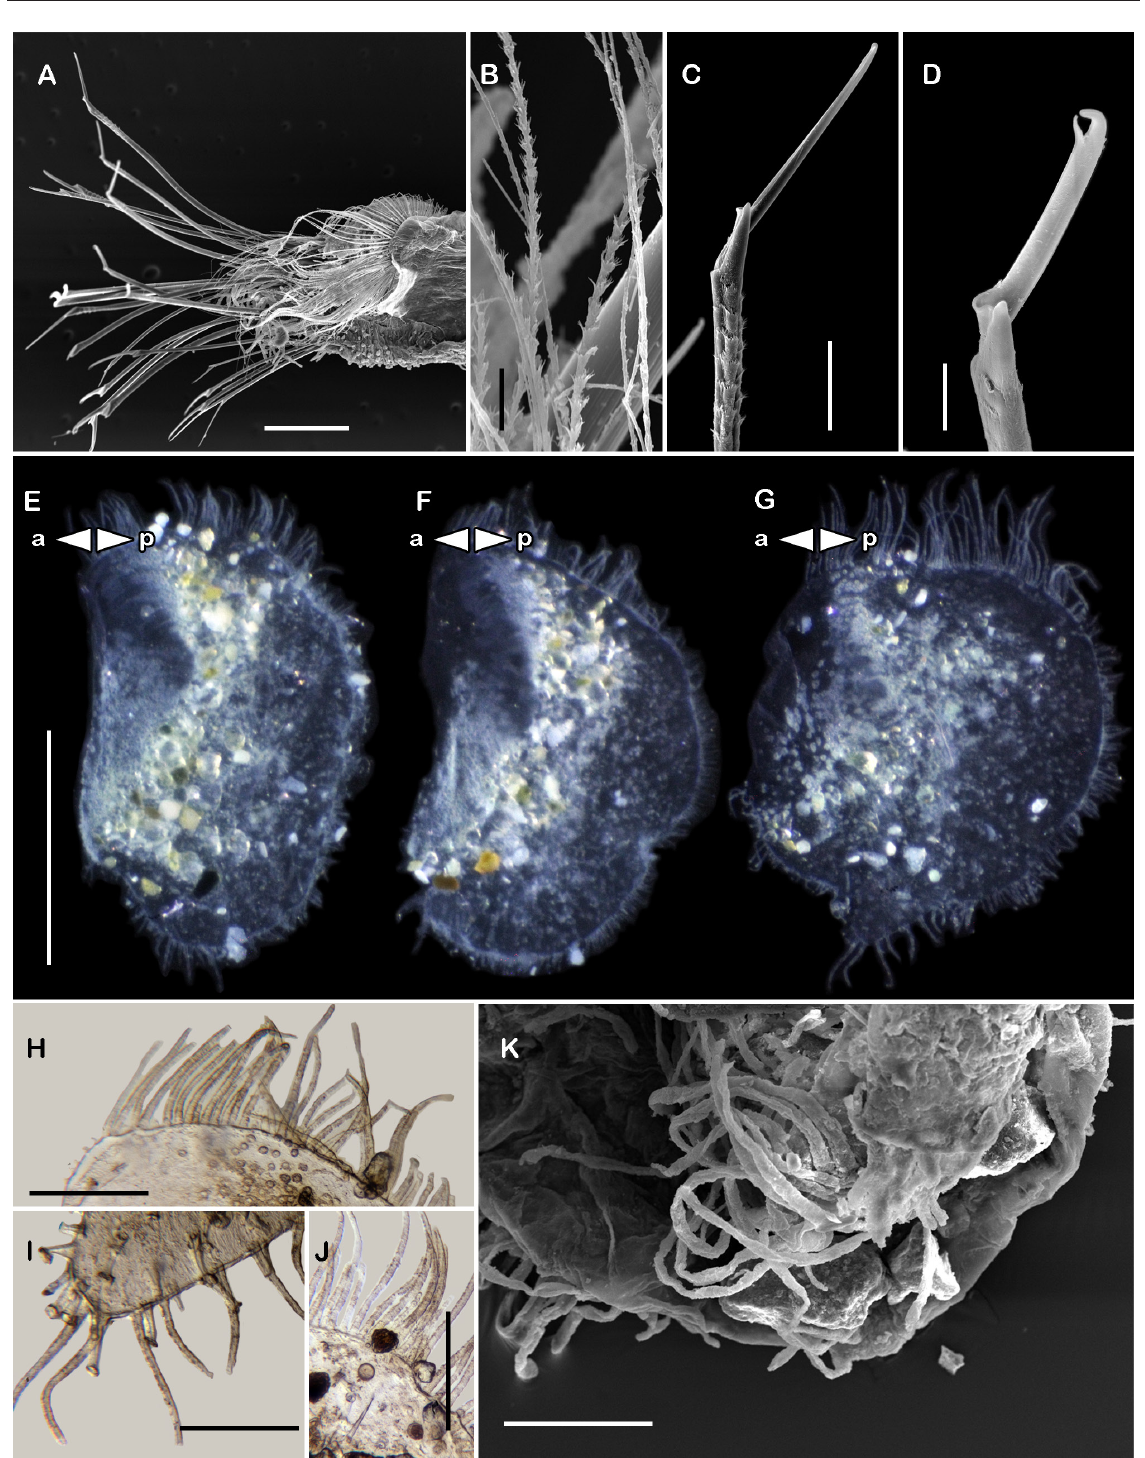
Fig. 12. Neopsammolyce aff. floccifera (Augener, 1906), non-type material (UMML 6607-393). A–D, K. SEM micrographs. A . Right parapodium from segment 27. B . Notochaetae from same. C . Unit A. D . Unit B. E . First left elytron. F . Third right elytron. G . Right posterior elytron. H . Detail of margin from E. I . Medial process from G. J . Margin from G. K . Surface of posterior elytron. Abbreviations: a = anterior; p = posterior. Scale bars: A = 200 μm; B = 10 μm; C, H–J = 50 μm; D = 20 μm; E–G = 1 mm; K = 100